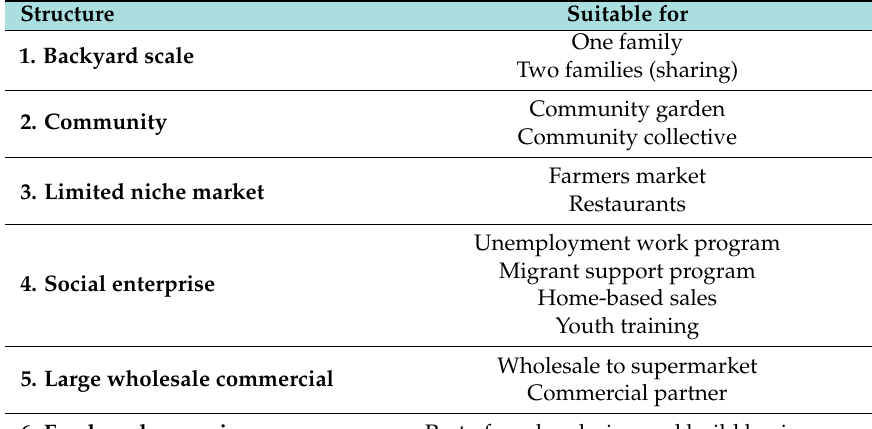
Table 2. Aquaponics business design